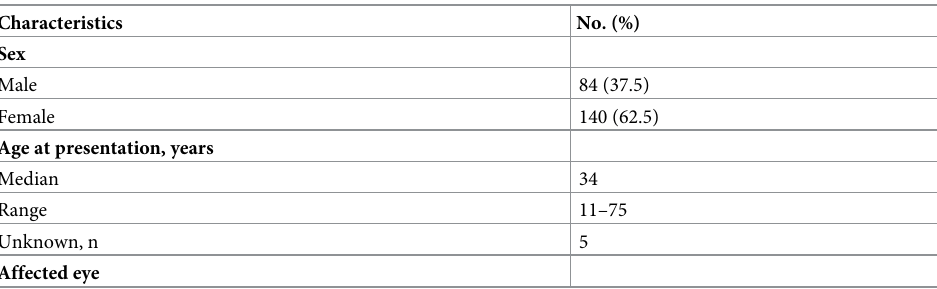
Table 1. Patient characteristics (n =